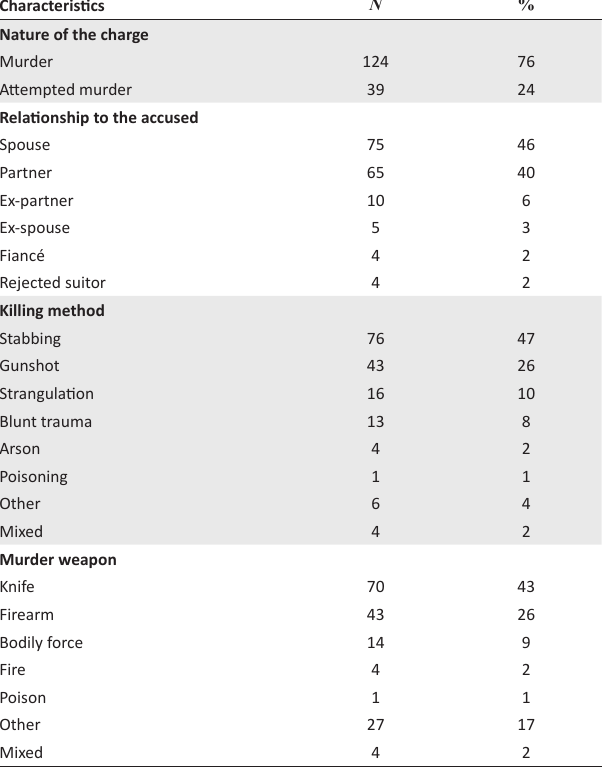
TABLE 2: Offence characteristics.